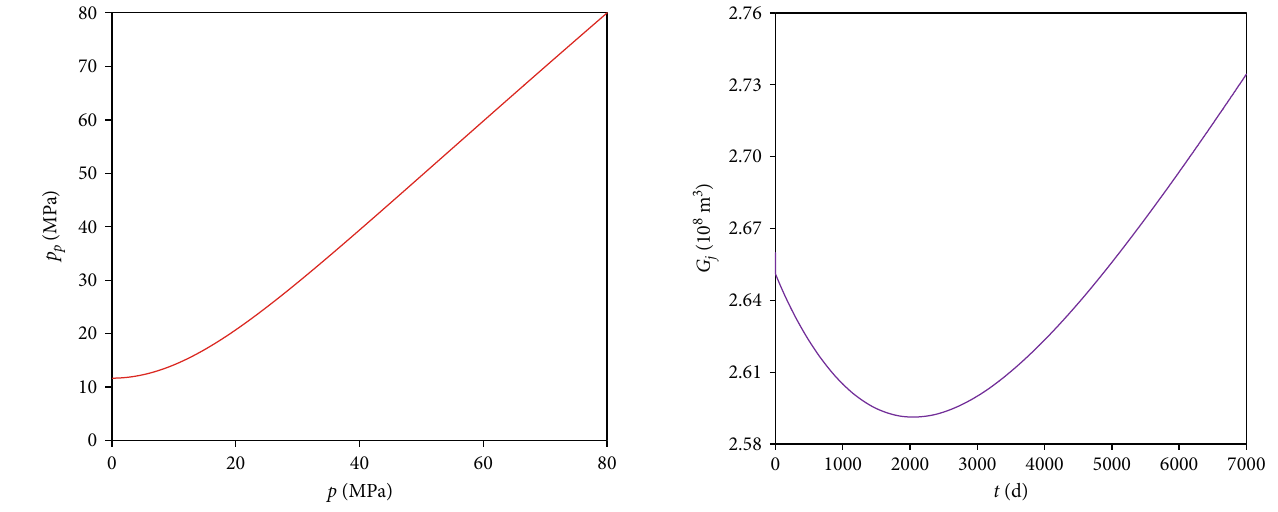
ð p Þ vs. p for the high-pressure p